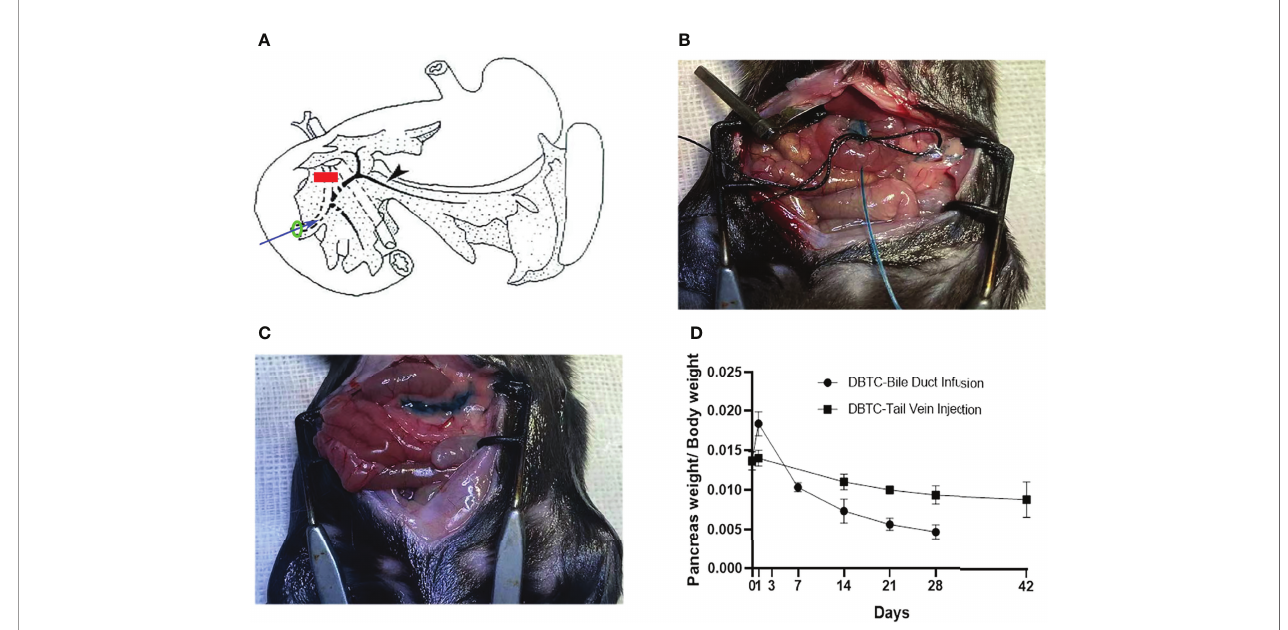
FIGURE 1 | (A) Schematic diagram of retrograde pancreatic duct injection of DBTC. Blue arrow, fi ne catheter to infuse DBTC solution; red line, clip to block distal biliary duct; black arrow, pancreatic duct; green ring, suture to secure biliary duct. (B) Intraoperative photographs of retrograde pancreatic duct injection of DBTC (during infusion). (C) Intraoperative photographs of retrograde pancreatic duct injection of DBTC (after infusion). Methylene blue (1%) is added to DBTC solution to trace pancreas parenchyma. (D) Percentage of pancreas weight/body weight in different groups. DBTC, dibutyltin